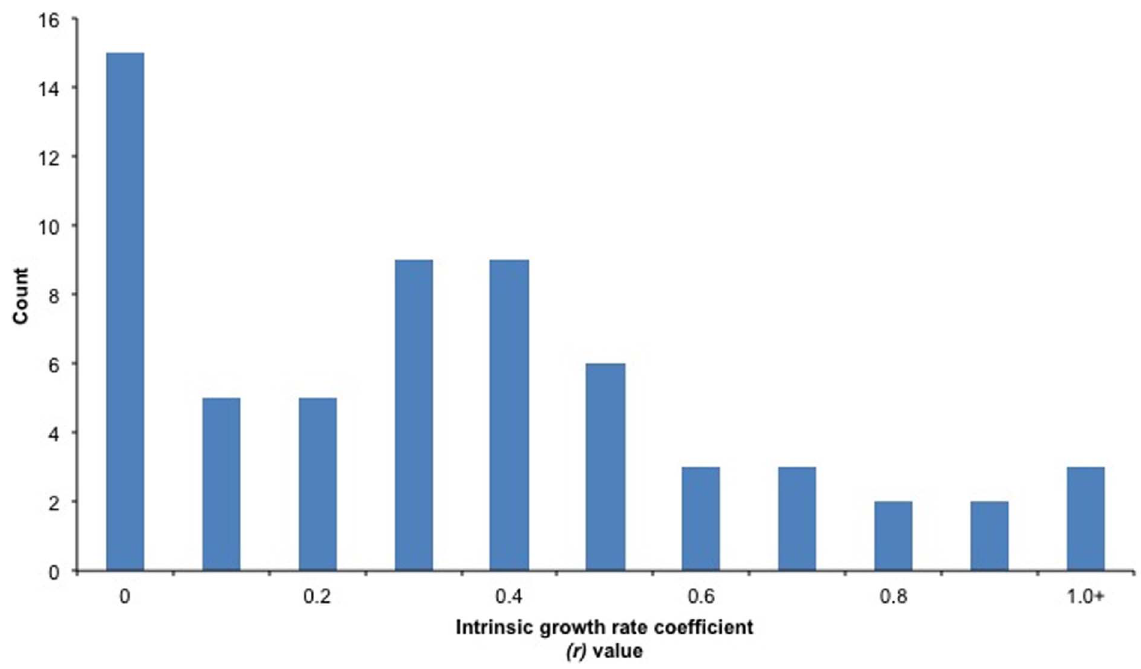
Figure 1. The distribution of intrinsic growth rate coefficients ( r ) for U.S. fish stocks, based on 62 stocks for which F msy or U msy values were available. Note that r values labeled 0 on the x -axis actually represent 0.01 to 0.09 values.